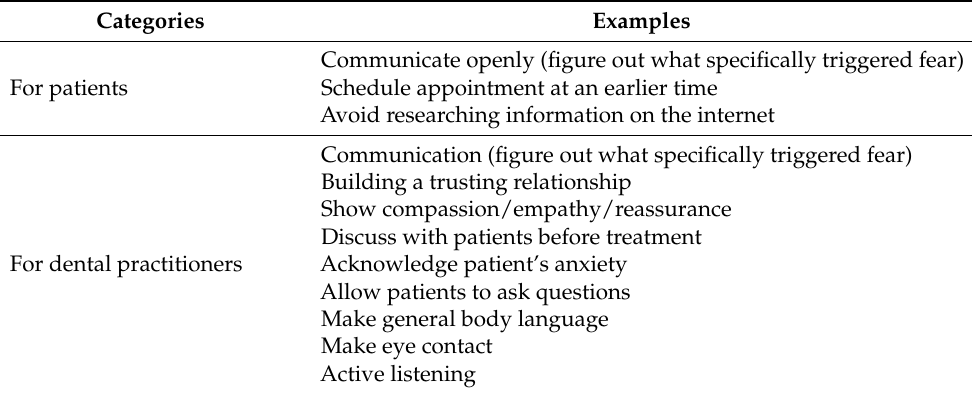
Table 9. General management techniques suggested in the